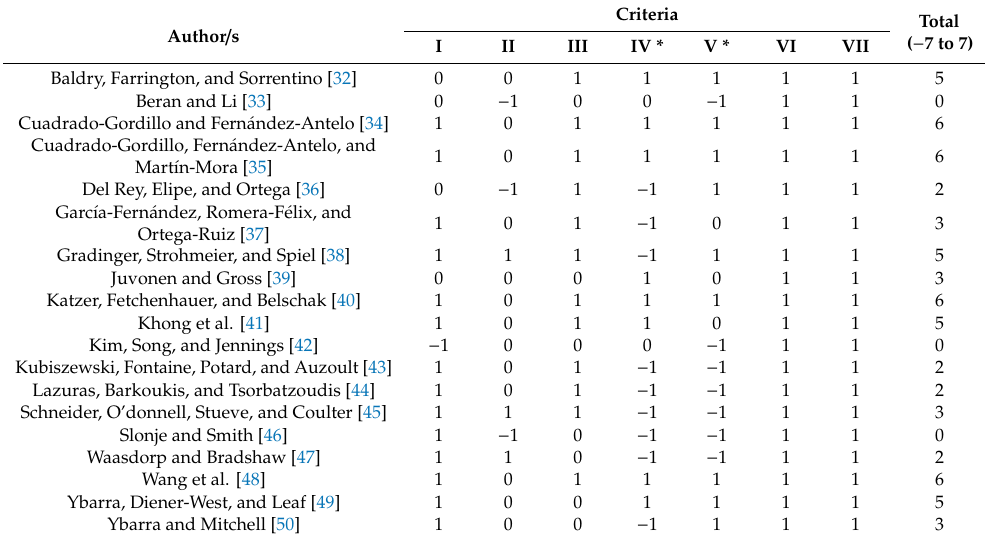
Table 1. Methodological quality of